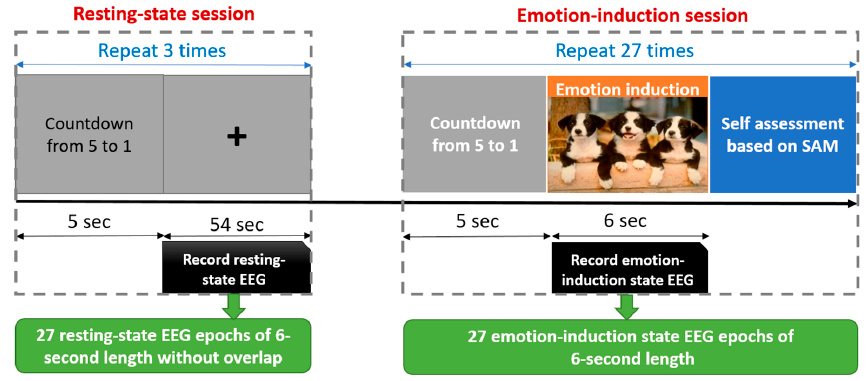
Figure 3. Trial sequence for the resting and emotion-induction states. EEG = electroencephalography.